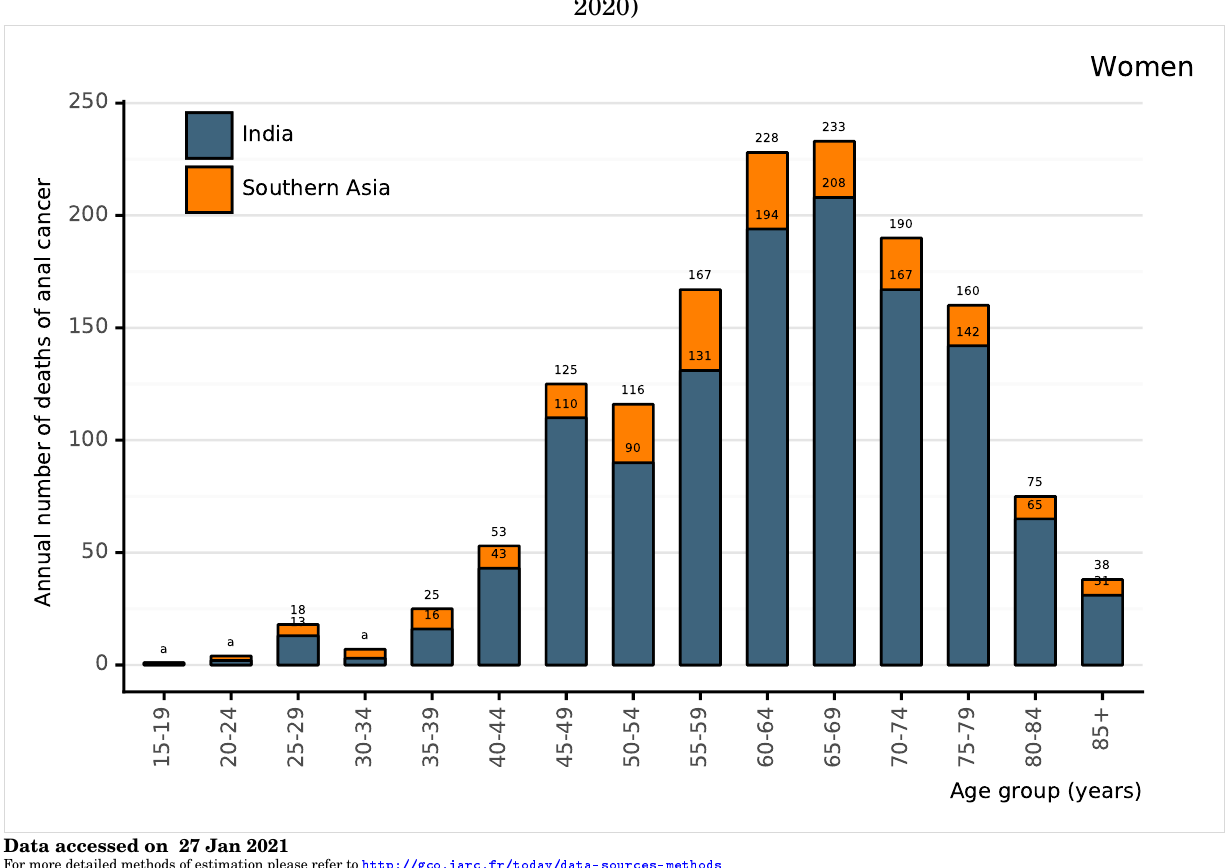
Figure 110: Annual number of deaths of anal cancer among women by age group in India (estimates